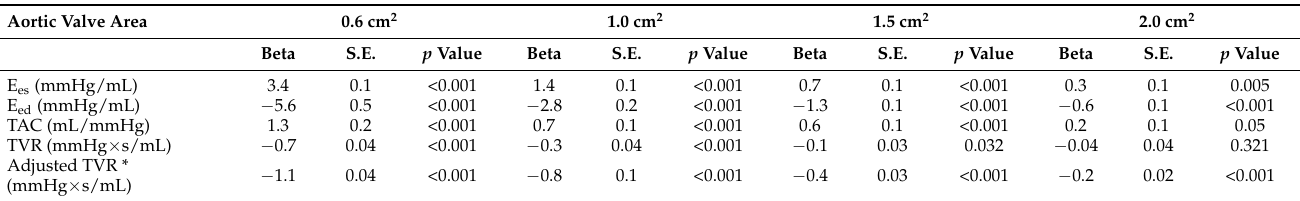
Table 1. Relative contribution of each determinant on TPG for different levels of aortic valve stenosis. Beta coefficients (Beta) are expressed in pressure (mmHg) for every 10% increase of each determinant from the baseline (lowest)